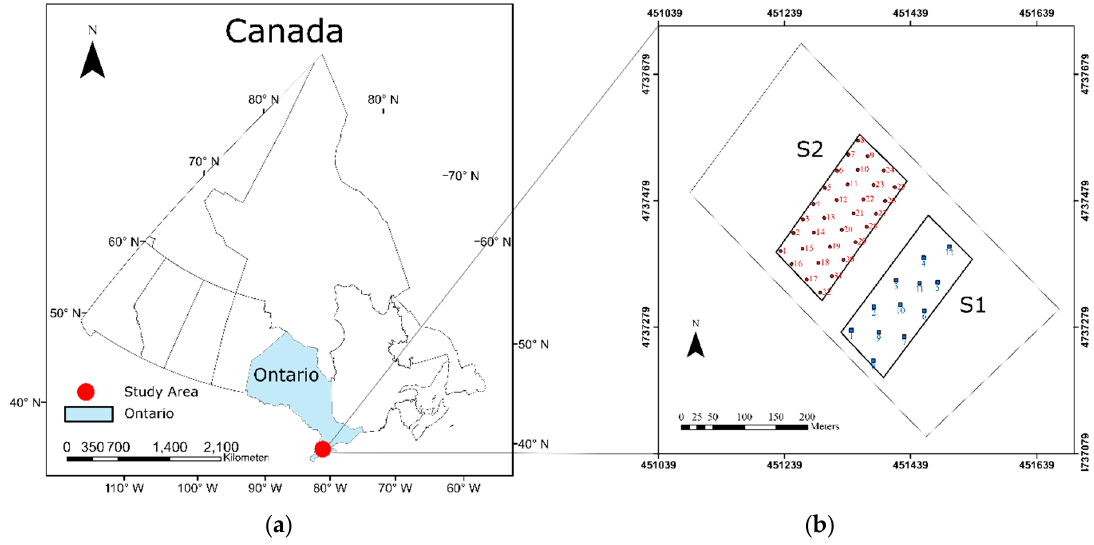
Figure 1. The maps of the winter wheat study site ( a ) shows the field geographical location in Canada; ( b ) shows the location of S1 and S2 in the wheat field. The blue points are the sampling locations in S1, and the red points are the sampling locations in S2.